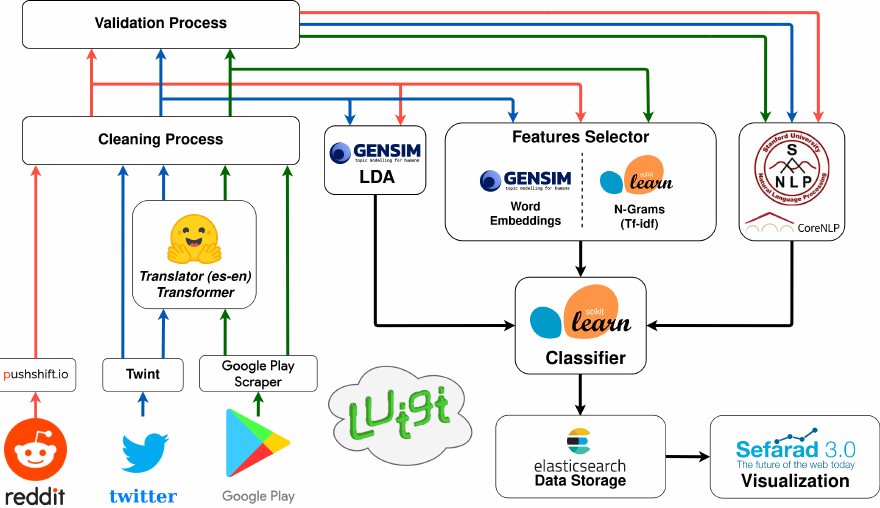
Figure 1. System architecture and an overview to every